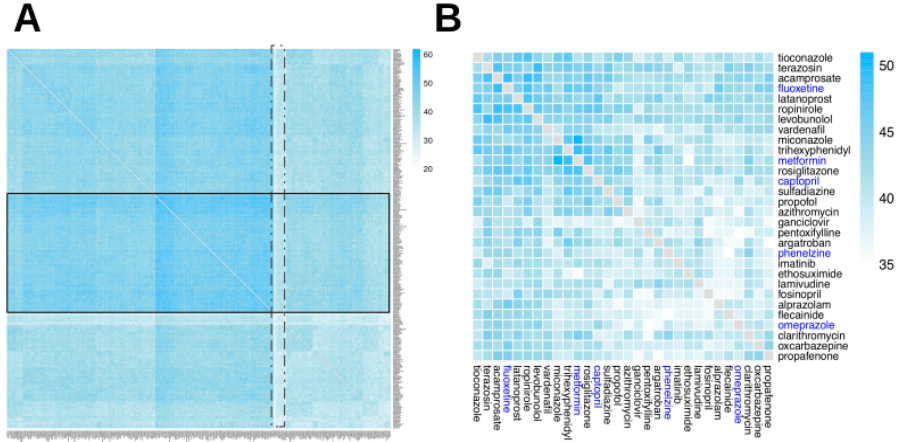
Figure 3. Composite ADR heatmap. Heatmap of two-drug combination composite ADRs (cADRs). Composite ADRs are reactions that may be caused by any of the drugs in the combination. The heatmap is organized using a hierarchical clustering (a connectivity-based grouping method, in which a set of dissimilarities is generated from the original matrix data, and each drug is iteratively assigned to a cluster). ( A ) The complete heatmap, containing all 315 drugs; a band of drugs with more cADRs (highlighted in a solid line rectangle), as well as a narrow band of drugs with few cADRs (highlighted in a dotted rectangle) are shown. ( B ) A subset of the heatmap, containing 35 drugs: five drugs highlighted in blue, which are used in examples in the Discussion section, and the six drugs most similar to each of them (in terms of the number of cADRs) from Panel A.